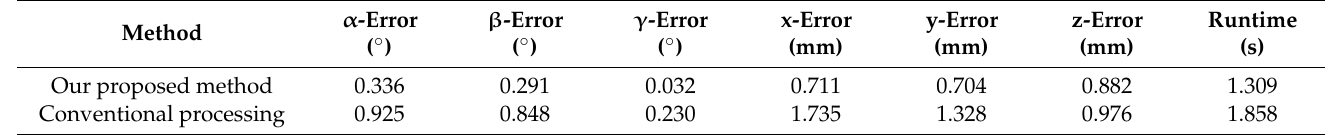
Table 8. Maximum of the absolute errors of each direction of freedom and runtime.